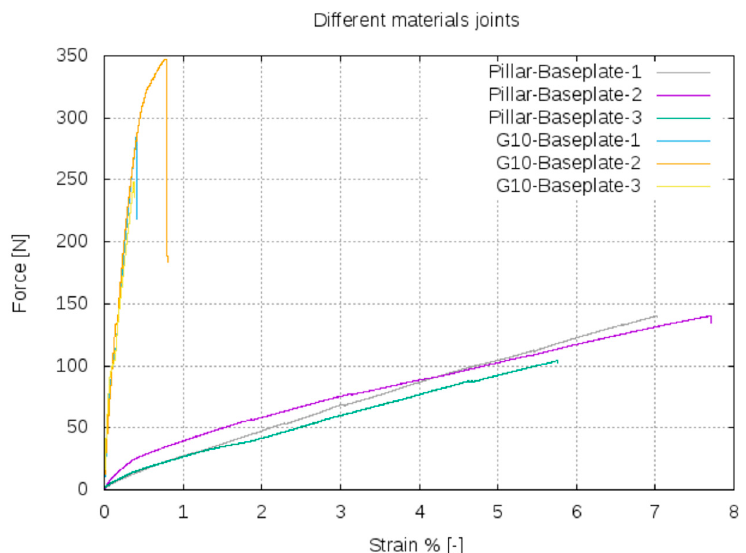
Figure 10. The tensile test of the different material joints.